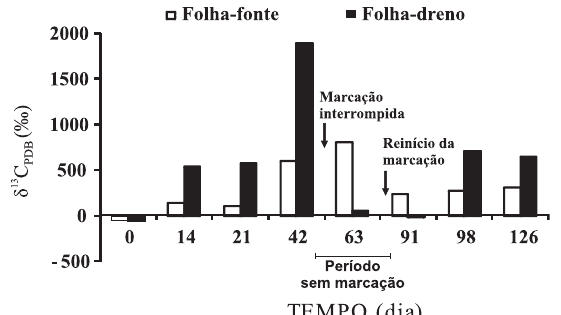
Figura 4. Médias de composição isotópica de 13 C de folhas-fonte e folhas-dreno ao longo do processo de marcação. As setas pretas indicam quando foi interrompido e reiniciado o processo de